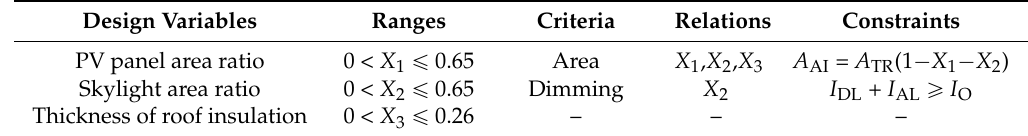
Table 4. Design Variables and